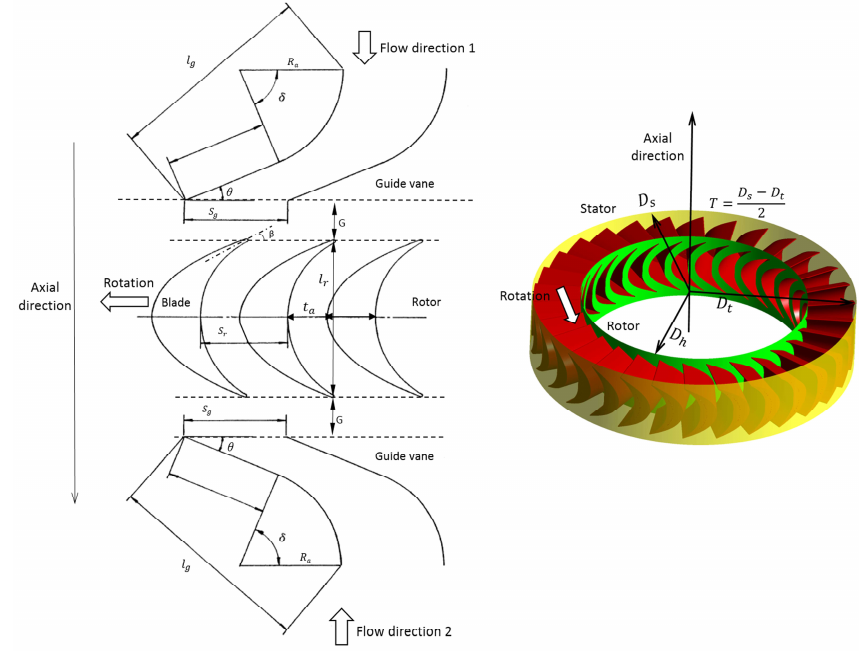
Figure 1. View of the impulse turbine. (Figure adapted from